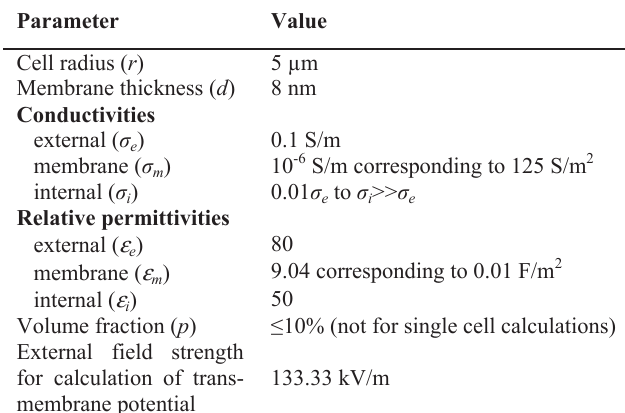
Table 1. Standard parameters of the spherical cell model.